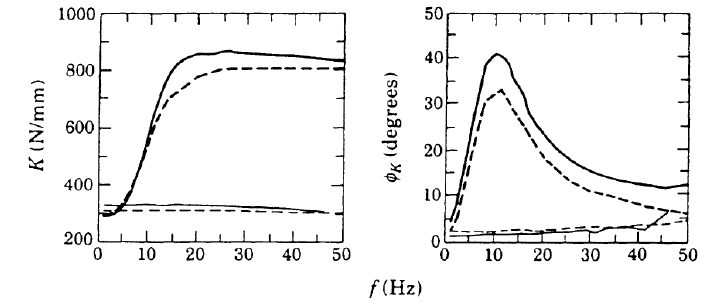
Fig. 5. Dynamic stiffness of hydraulic mount with decoupler [6].